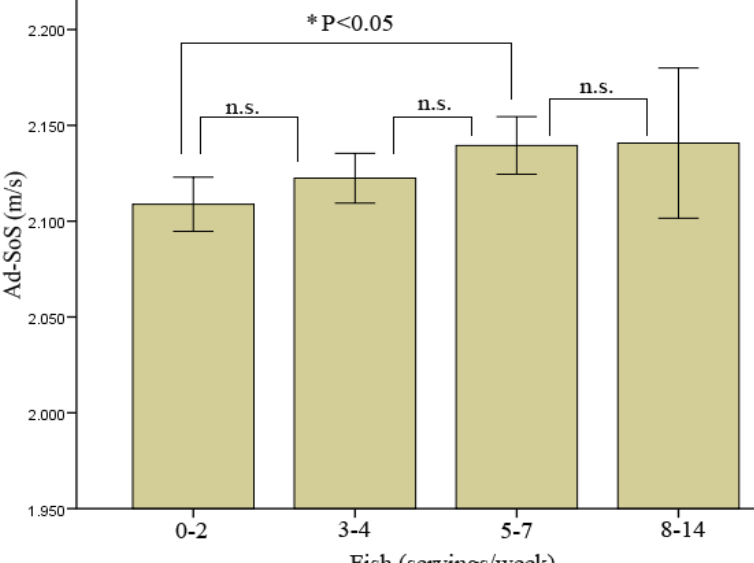
Figure 2. Association of fish intake on bone mass measured at the phalanges in premenopausal Spanish women. Values expressed as mean ± SD. * P < 0.05, n.s. (not